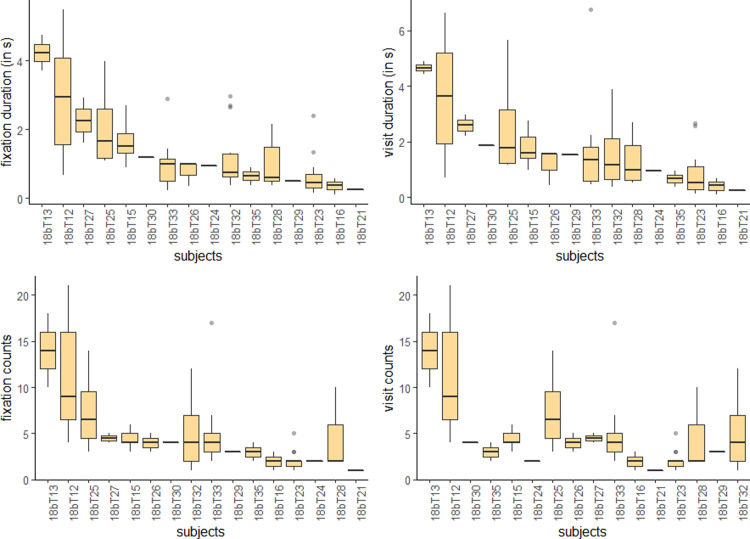
Individual differences for eye tracking measurements.Boxplots show individual measures for maintained attention (n = 83).